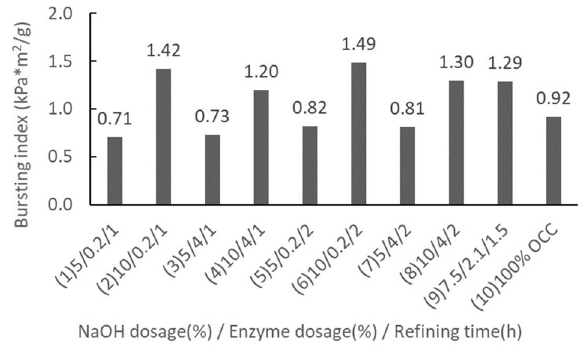
Figure 8. The effects of rice straw semi-chemical mechanical pulp on the burst index of handsheets.